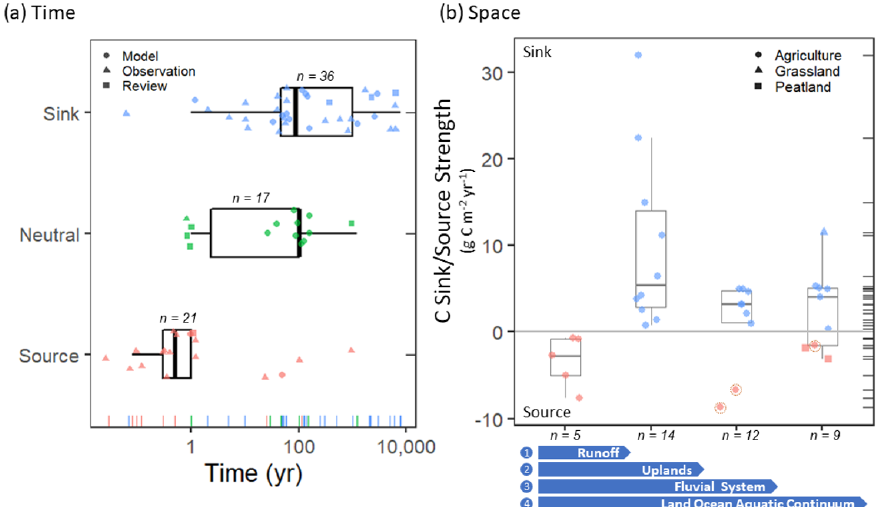
Figure 2. Effect of time and space on the erosional sink versus source term reported in the literature. Panel (a) shows how the reported OC source versus sink by water erosion is influenced by the timescale considered in the study (74 studies). Panel (b) shows how the magnitude of the reported water-erosion-induced OC source–sink strength is influenced by the spatial scale considered in the study (40 studies). We classify the studies in four spatial scales along the geomorphic cascade (see Table 1): (1) studies that only consider runoff in uplands; (2) studies that provide an assessment at the scale of eroding uplands (eroding soils and colluvium); (3) studies that consider eroding soils, colluvium, and alluvium; and (4) studies that consider the full geomorphic cascade (including the aquatic component). Estimates which do not account for OC recovery at eroding sites for scales 3 and 4 are encircled with a dotted line. Further details on the studies used are given in Table 1.